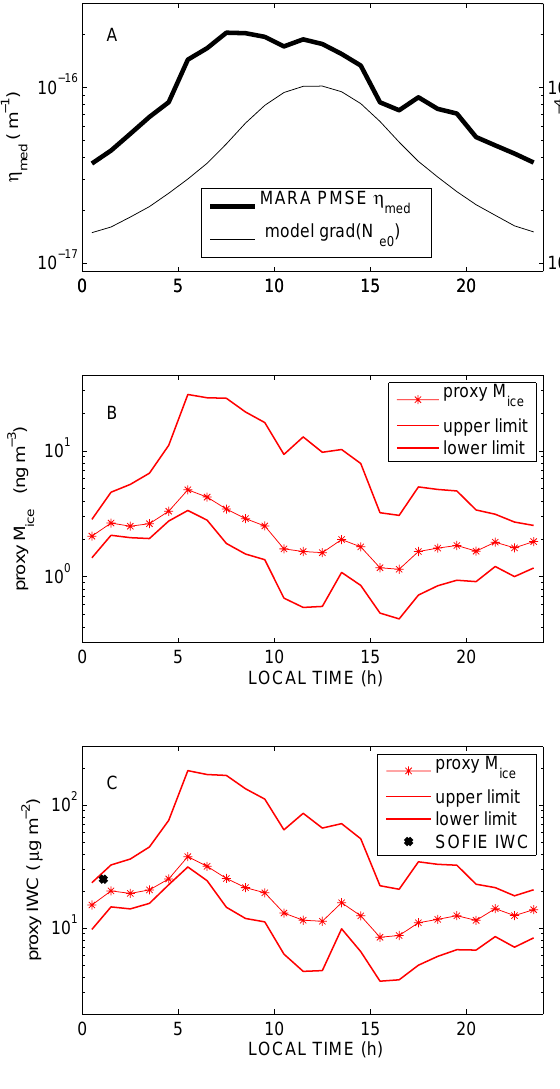
Fig. 6. Panel (A) Daily variation of measured PMSE volume re- flectivity (median values) and average background electron density between 84km and 90km heights (top panel). Panel (B) proxy for ice mass density calculated from the parameters in the upper panel panel. Panel (C) daily ice-water column found by integrating the proxy ice-mass density from 75km to 100km altitude. The corre- sponding mean ice-water column from SOFIE is shown by the cross at 01:00LT (for the measurements in Fig. 1 when Ap < 15). Proxy values are represented as the most likely values (thin red line with *) and by the upper and lower limits for the 67% confidence levels (thin red lines without markers). See text for further details.